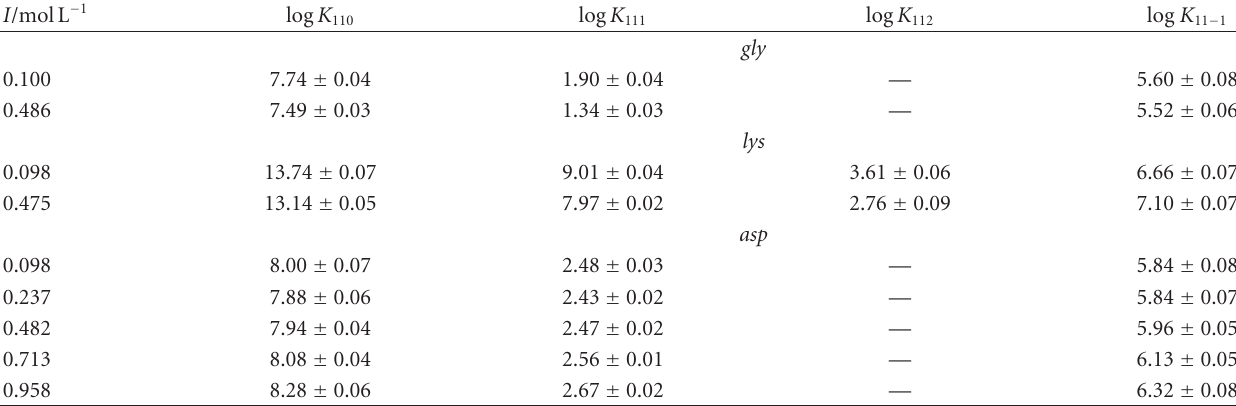
Table 3: Stability constants of dimethyltin(IV)/aminoacid species, in NaCl aq at di ff erent ionic strengths (in mol L − 1 ), and t = 25 ◦ C. log K pqr refer to equilibria reported in (2)-(4); ± standard deviation.